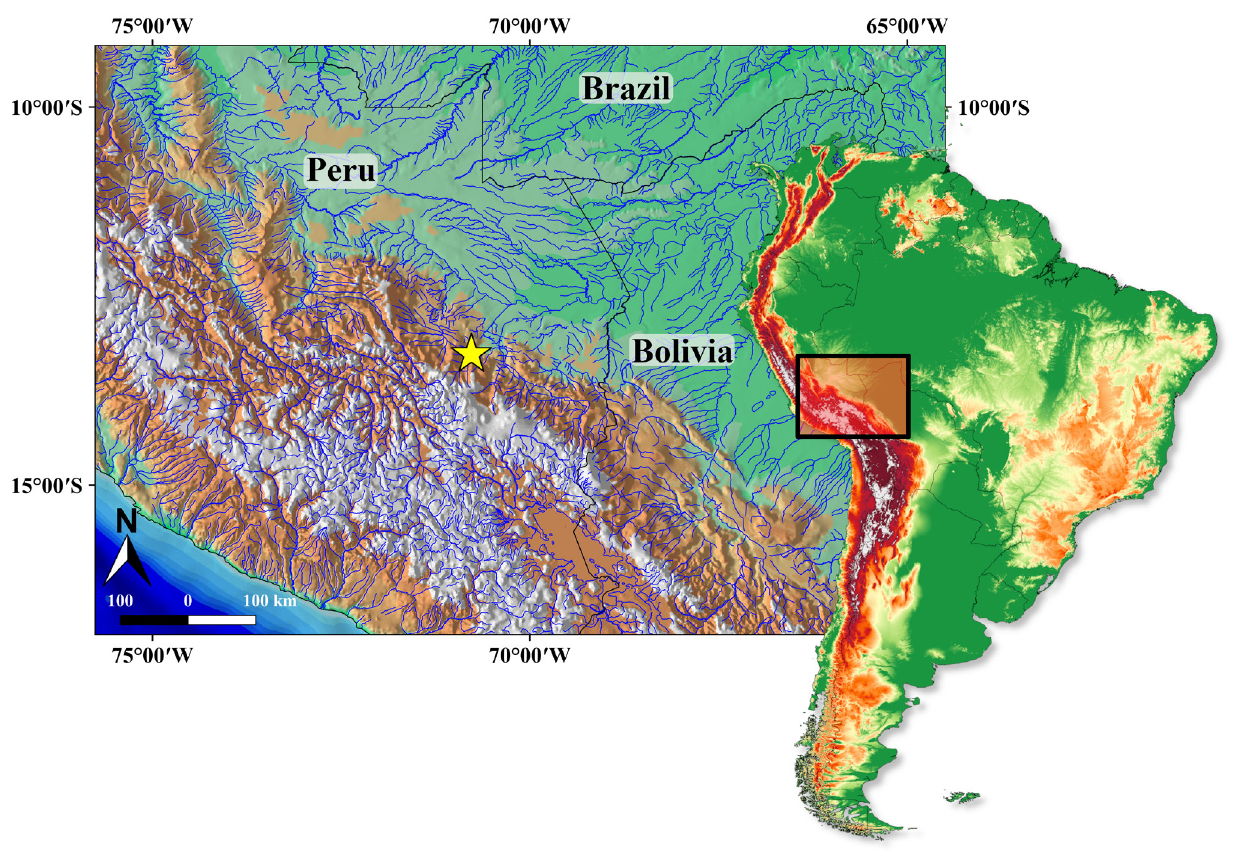
FIGURE 10 | Map showing the geographical distribution of Corydoras maclurei (yellow star). The symbol represents more than one